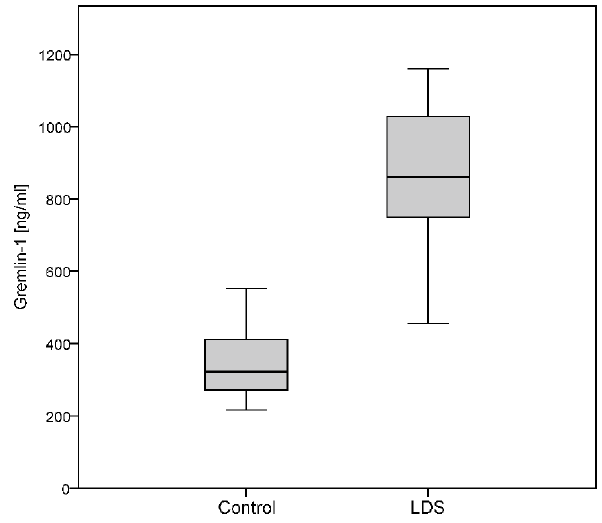
Figure 3. Gremlin-1 plasma levels are significantly increased in LDS patients. Gremlin-1 plasma levels of LDS patients (n=9) were analysed in an enzyme-linked immunosorbent assay. Compared to healthy donors (n=15), mean plasma levels of Gremlin-1 were 2.5-fold increased in LDS patients (Welch’s t-test p , 0.001). Box plots show the median (central horizontal line), the 25th to the 75th percentile (box) and the range (whiskers).